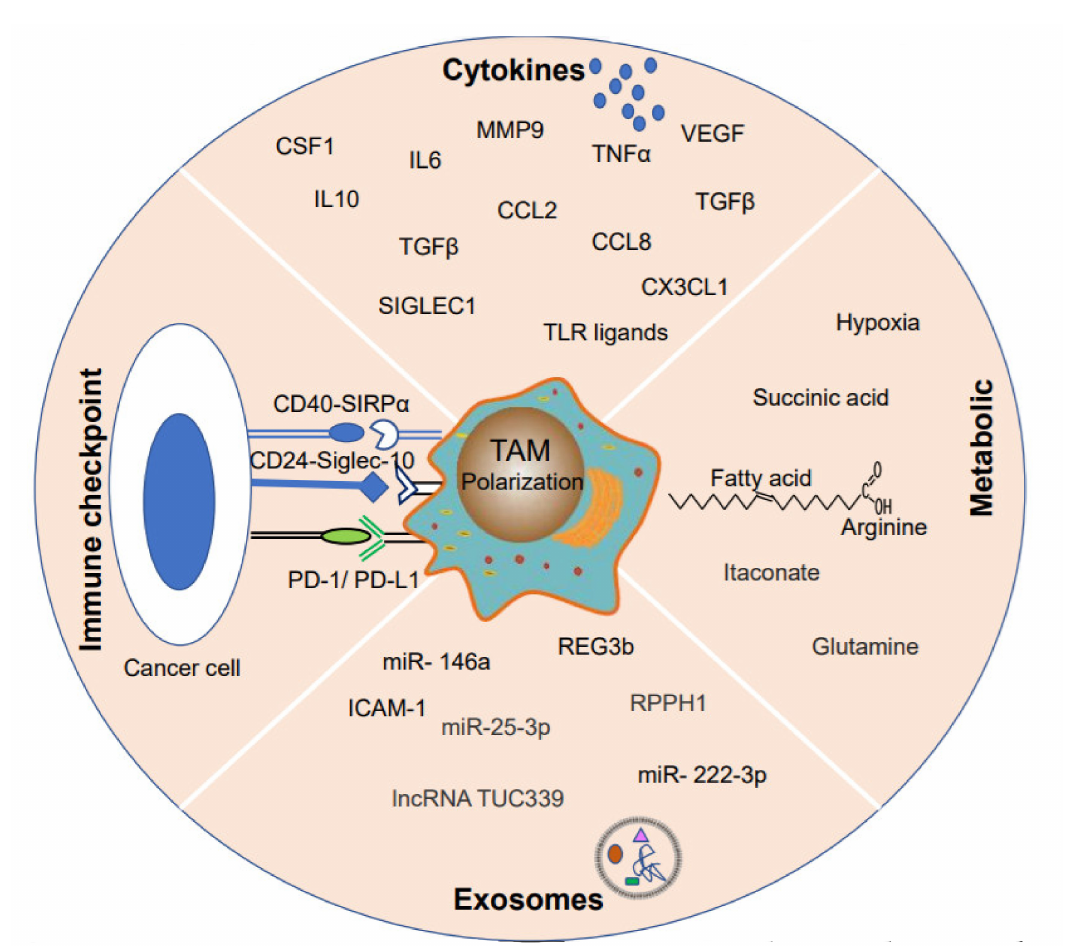
Figure 2. The crosstalk of tumor cells and TAMs. Tumor cells secrete different cytokines or exosomes to polarize macrophages into TAMs directly and hijacking macrophages by metabolites or limiting oxygen concentration indirectly. On the other hand, the polarized TAMs express PD-L1, SIRP α , or Siglec-10 to inhibit the anti-tumor